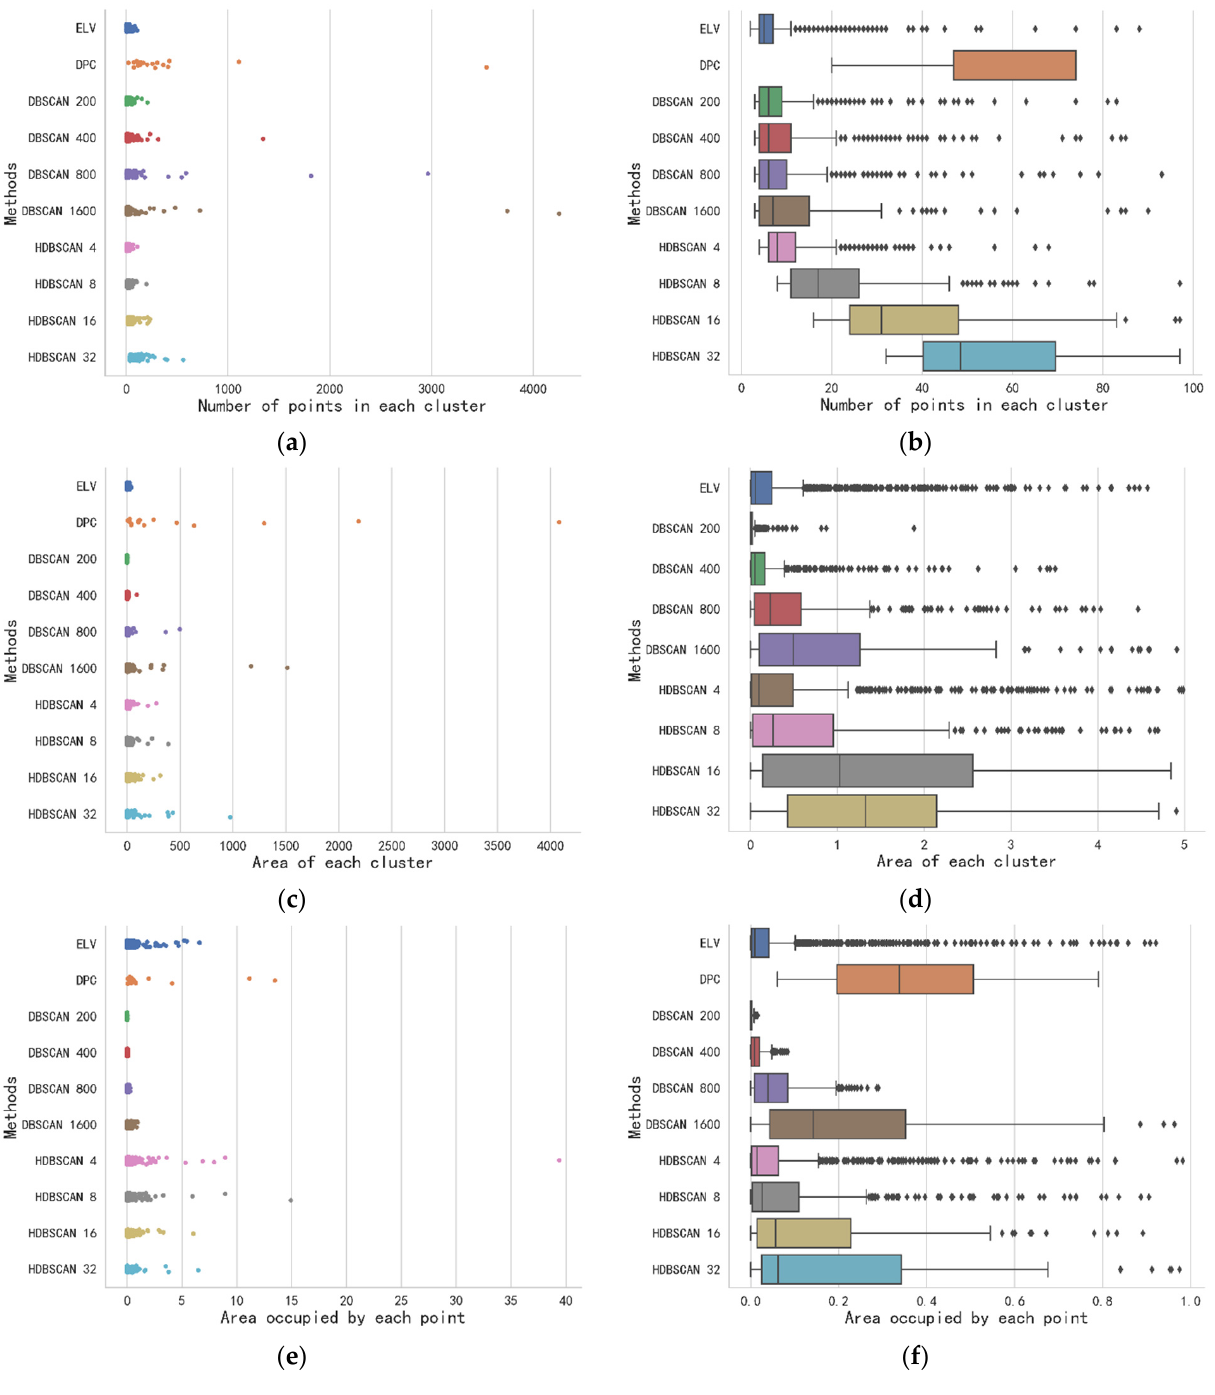
Figure 10. Detailed information related to the number of points and area of clusters: ( a ) scatter plot of the number of points in each cluster, ( b ) box plot of the number of points in each cluster, ( c ) scatter plot of area of each cluster, ( d ) box plot of area of each cluster, ( e ) scatter plot of the area occupied by each point, and ( f ) box plot of the area occupied by each point.